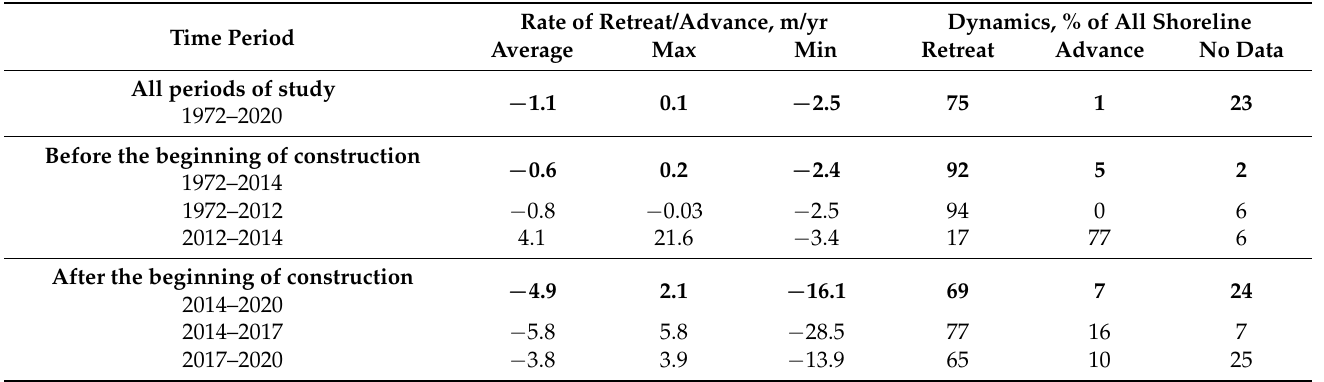
Table 1. Dynamics of the shoreline.